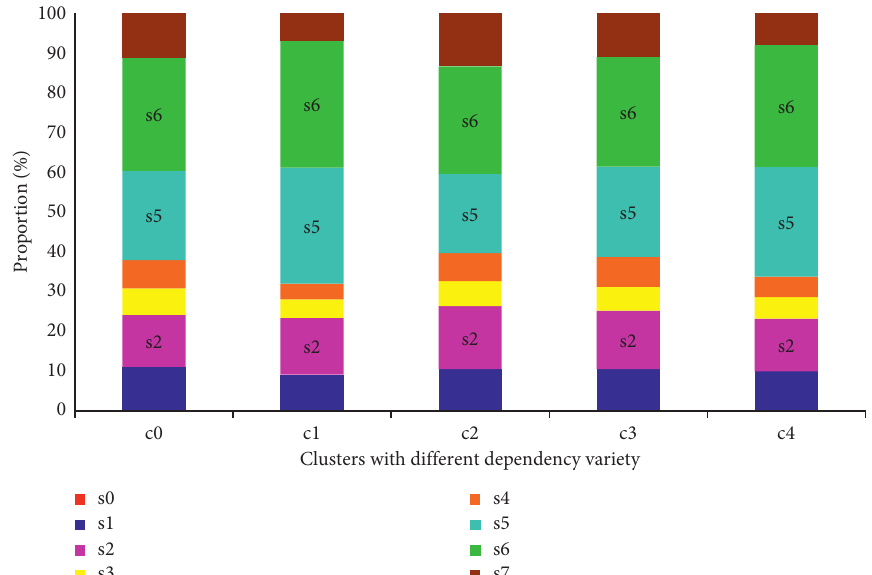
Figure 7: Specific proportion distribution over station functionality.